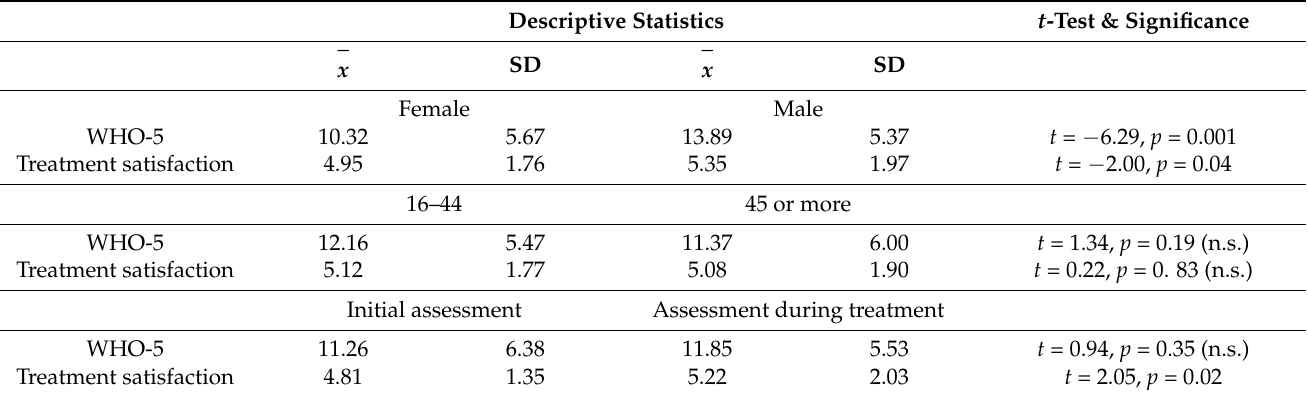
Table 3. Descriptive Statistics and Comparison analysis according to sex, age, and assessment moment.